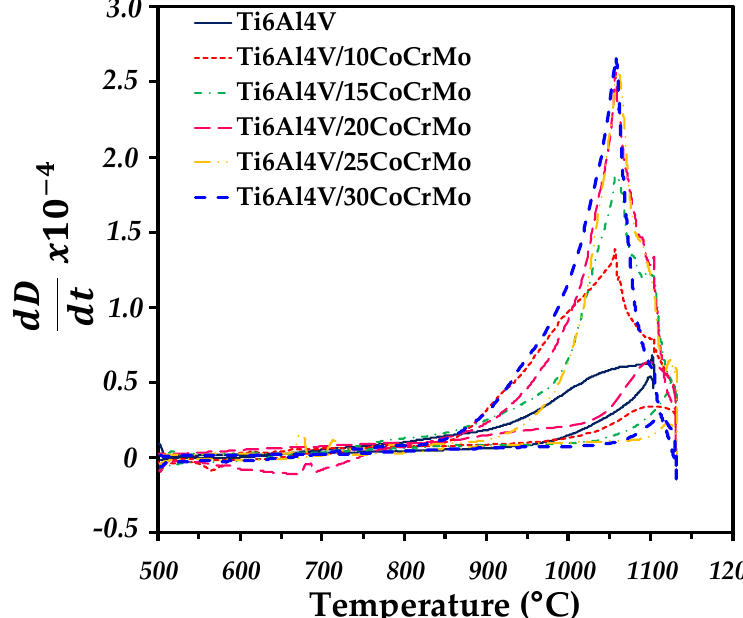
Figure 7. Densification rate as a function of temperature for all the samples.